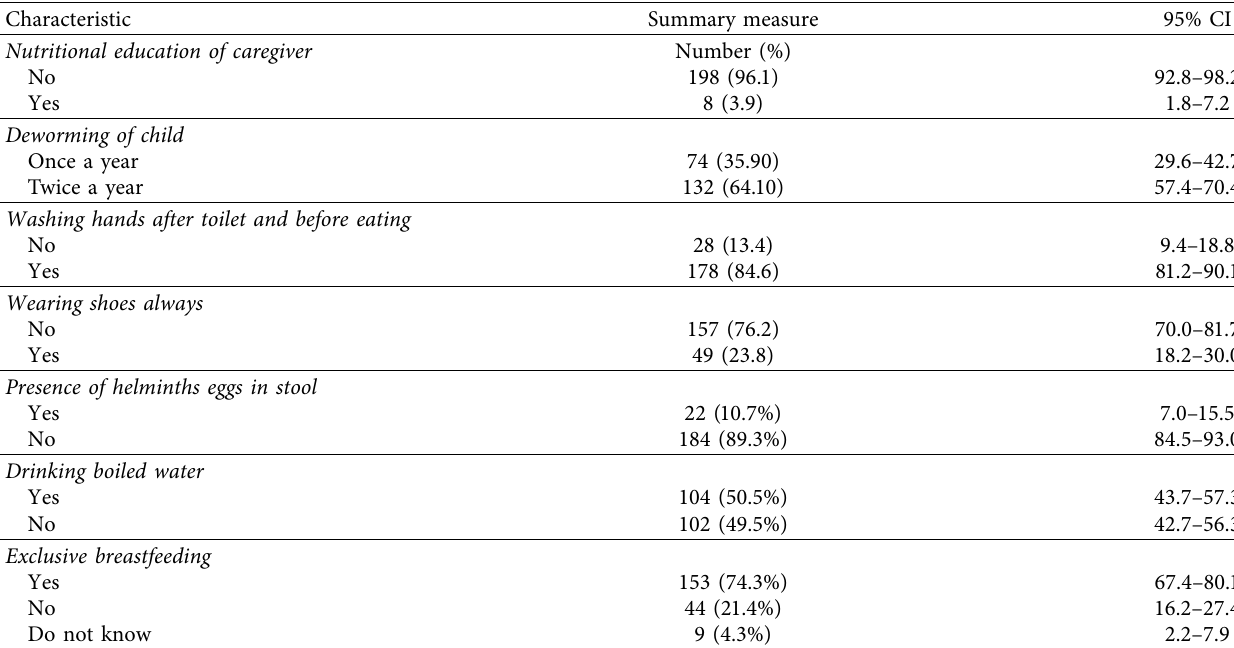
Table 2: Clinical factors associated with malnutrition in children aged 1–5 years attending the selected health units in Bushenyi district. Characteristic